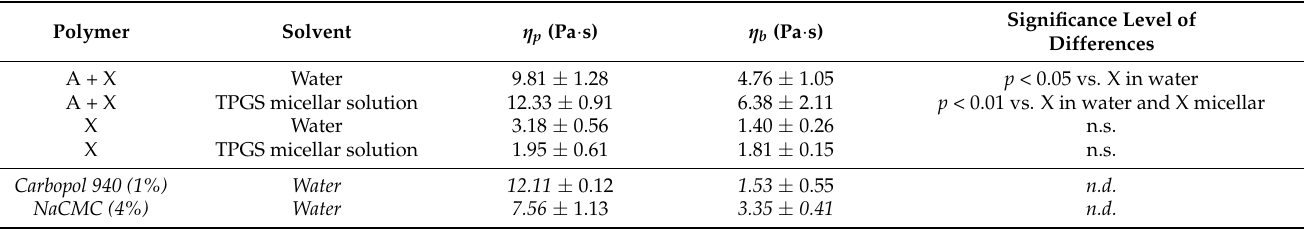
Table 3. Polymer solution viscosity ( η p ) and viscosity component of bioadhesion ( η b ) (mean value ± sd).